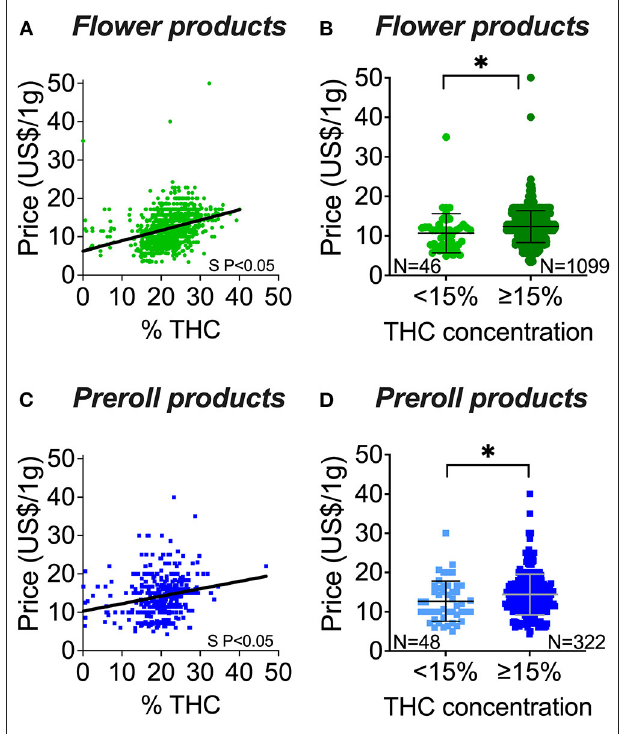
FIGURE 1 | Cannabis potency (THC content) and price associations. (A) THC and price correlation of all herbal products. (B) Price distribution of products with < 15% THC in comparison to products with ≥ 15% THC. (C) Comparison of THC content (%) between flower and preroll products. (D) Comparison of price (US $) between flower and preroll products. S P < 0.05 denote significantly non-zero slope (A). * P < 0.05 between the mean values of the groups (B–D) by Welch’s t -test (unpaired, two-tailed). Data shown as mean ± SD (B–D) .